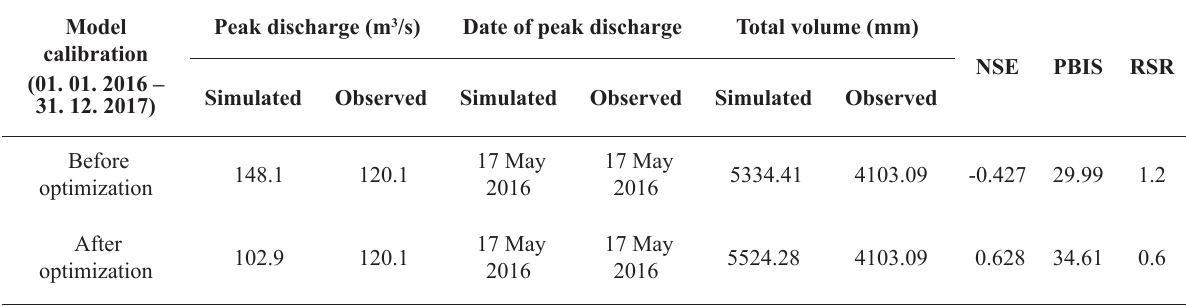
Before optimization After optimization